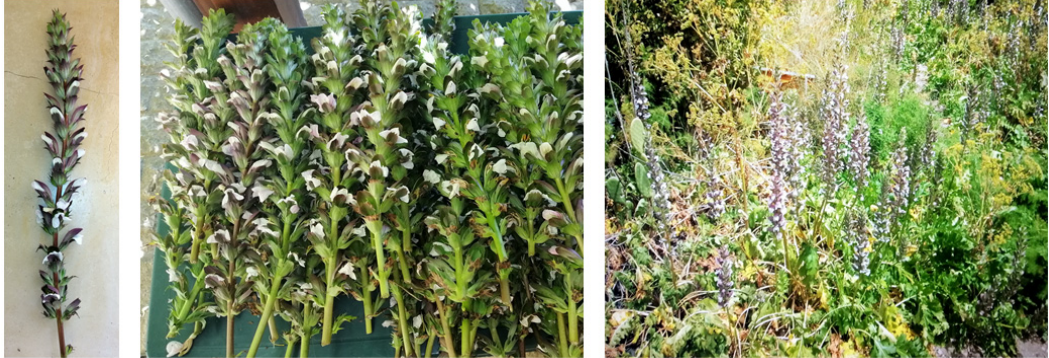
Figure 1. Orobanche crenata Forssk.